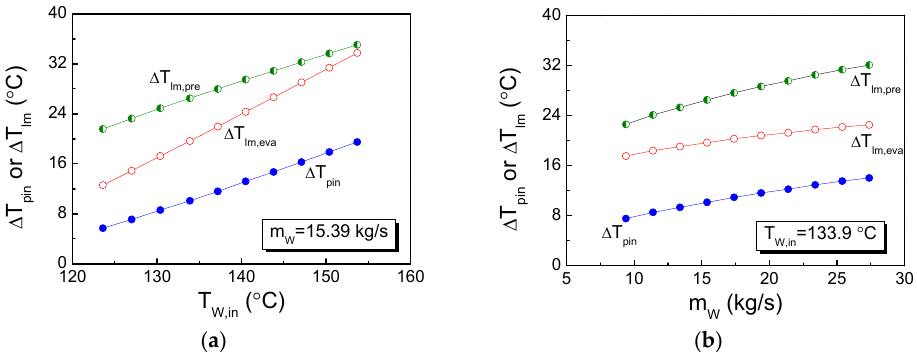
Figure 3. Pinch point and logarithmic mean temperature differences of the preheater and evaporator as functions of ( a ) T W,in and ( b ) m W .